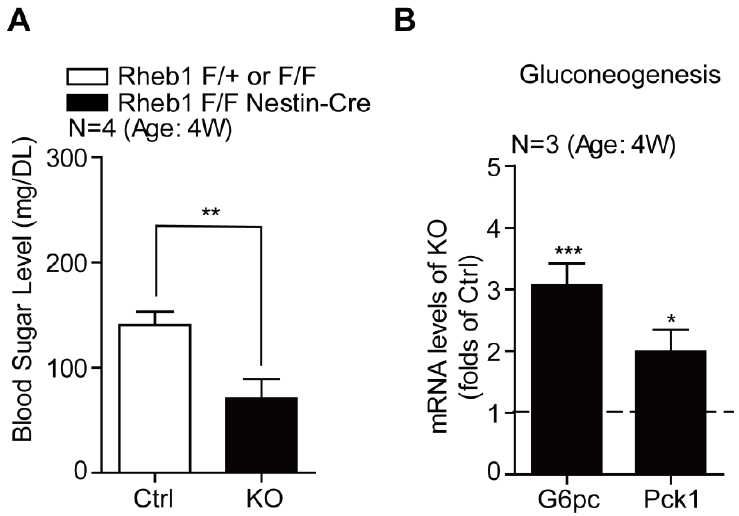
Figure 2. Genetic deletion of Rheb1 in the brain leads to hypoglycemia. ( A ) Biochemical assays showing the robust reduction of blood glucose level in Rheb1 ko mice compared controls ( N = 4). Results are averages of four independent animals. Data represent mean ± SEM. ** p < 0.01; ( B ) Real-time PCR assays showing the increasing mRNA levels of G6pc and Pck1 in livers of Rheb1 ko mice ( N = 3). Results are averages of